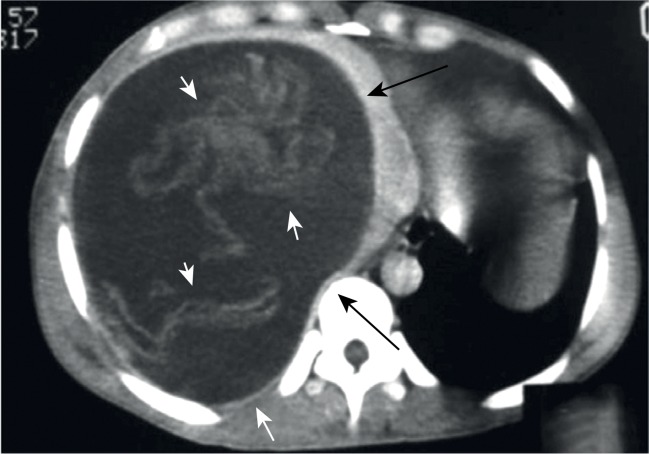
TC de tórax com janela para o mediastino, com contraste intravenoso.
Presença de volumosa massa cística (setas) de contorno regular e limites
bem definidos, ocupando e abaulando todo o terço inferior do hemitórax
direito e cruzando a linha média. É possível notar o realce periférico
pela substância de contraste e o típico pregueado (cabeças de seta) em
seu interior, correspondendo à compressa retida.